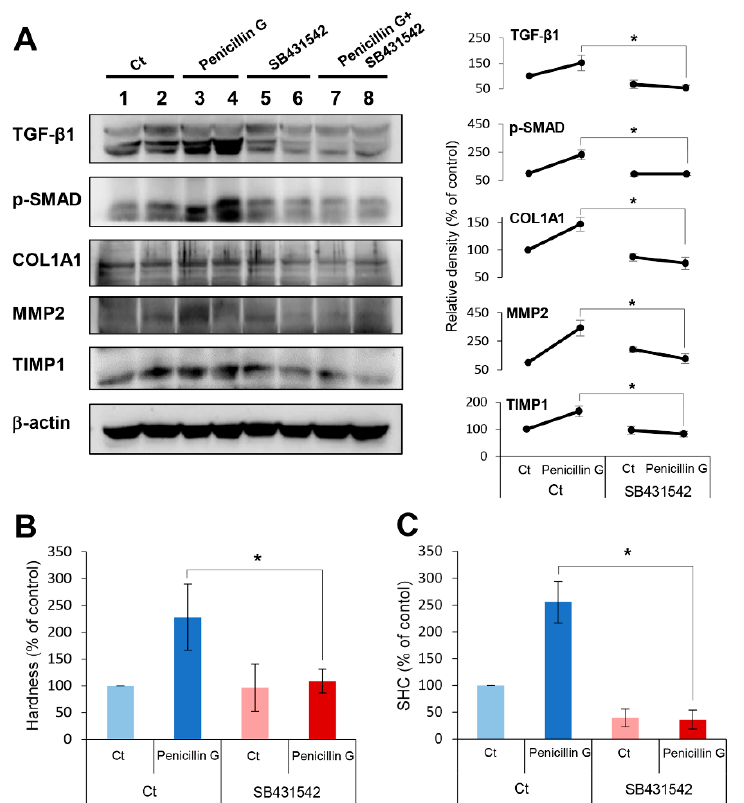
Figure 6. In vivo demonstration of mechanism leading to pancreatic fibrosis by penicillin G. Mice were injected with SB431542, an inhibitor of the TGF- β 1 receptor intraperitoneally, followed by an intra-pancreatic injection of penicillin G. ( A ) Western blot analysis showing the expression of fibrosis-related markers in the mouse pancreas. Pretreatment with SB431542 in mice injected with intrapancreatic penicillin G significantly reduced the expression of fibrosis-related markers, such as TGF- β 1, p-SMAD, collagen, MMP2, and TIMP1, in comparison with mice without the pretreatment ( p < 0.05). ( B ) Measurement of pancreatic hardness. Pretreatment of SB431542 significantly abrogated the pancreatic hardening capacity by penicillin G in the mouse pancreas. ( C ) Measurement of SHC of the pancreas. Pretreatment of SB431542 significantly abrogated the enhanced SHC induced by penicillin G in the mouse pancreas. Values are presented as mean ± standard deviation of three independent experiments. * p < 0.05. Abbreviations: Ct, control; MMP-2, metalloproteinases-2; p-SMAD2, phosphorylated Smad2; SHC, suture holding capacity; TGF- β 1, transforming growth factor- β 1; TIMP-1, tissue inhibitor of metalloproteinases-1.